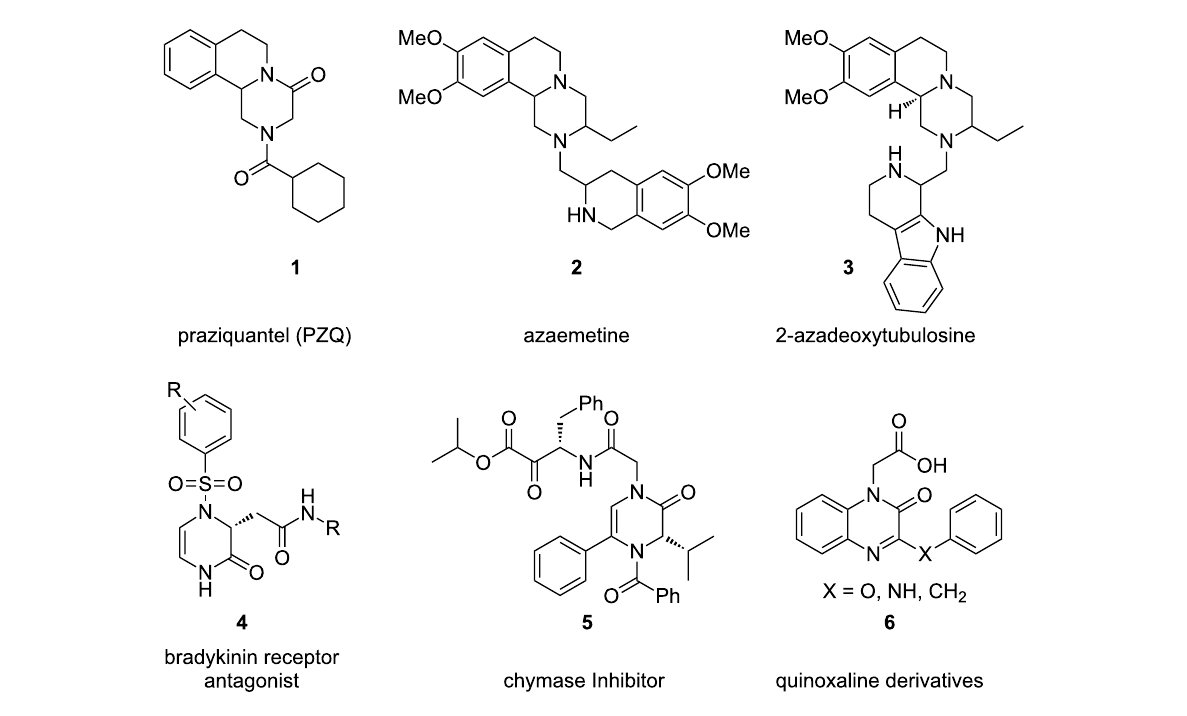
Figure 1: Selected active pyrazinoisoquinolines, 2-oxopiperazines and aldose reductase inhibitors (ALR2).